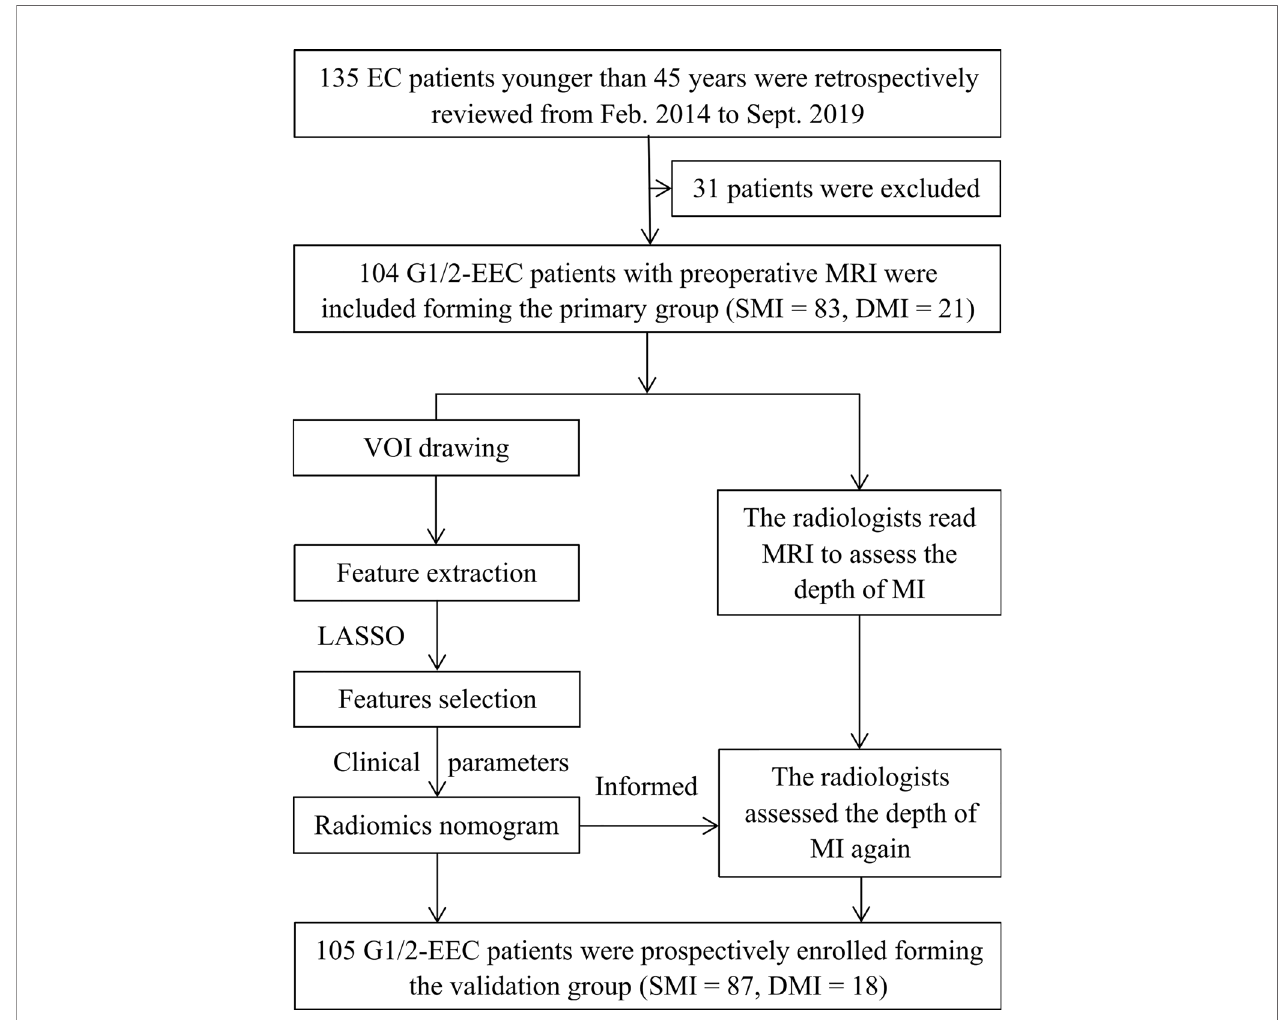
FIGURE 1 | The work fl ow of this study. G 1/2, grade 1 and 2; DMI, deep myometrial invasion; EC, endometrial cancer; EEC, endometrioid adenocarcinoma; SMI, super fi cial myometrial invasion; MI, myometrial invasion; LASSO, least absolute shrinkage and selection